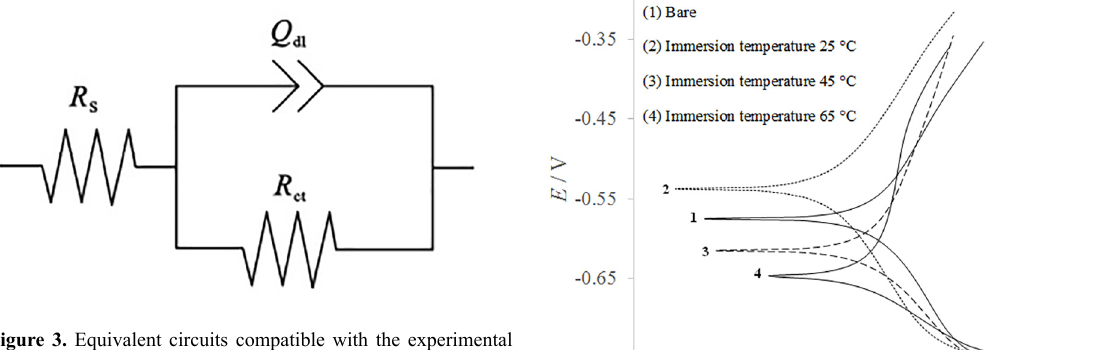
Figure 3. Equivalent circuits compatible with the experimental impedance data in Figure 2 for corrosion of cerium oxide coated steel electrode.